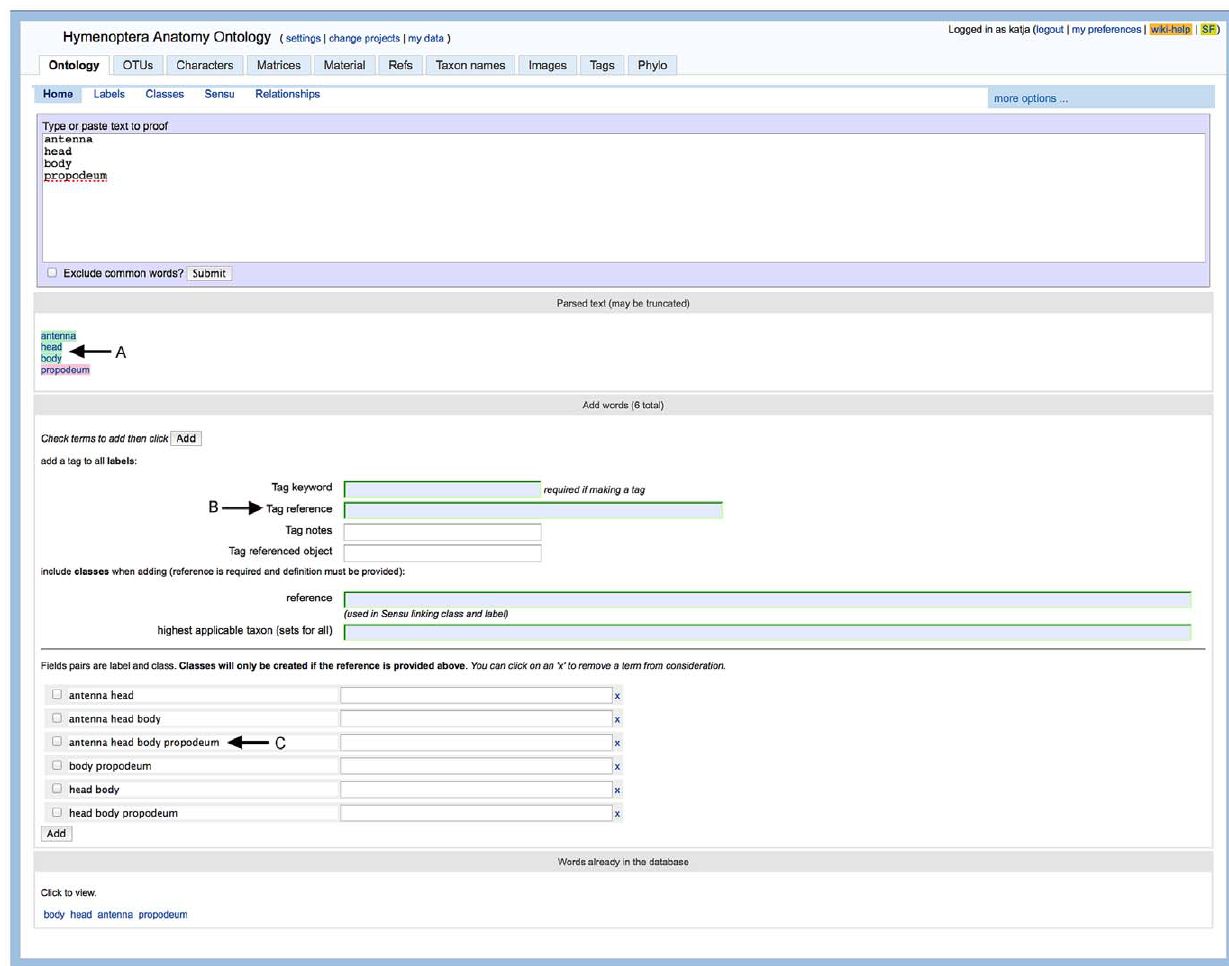
Figure 1. Screenshot of the mx interface for string matching terms in the database with OCR text. Possible additional new terms are proposed for the user to include.